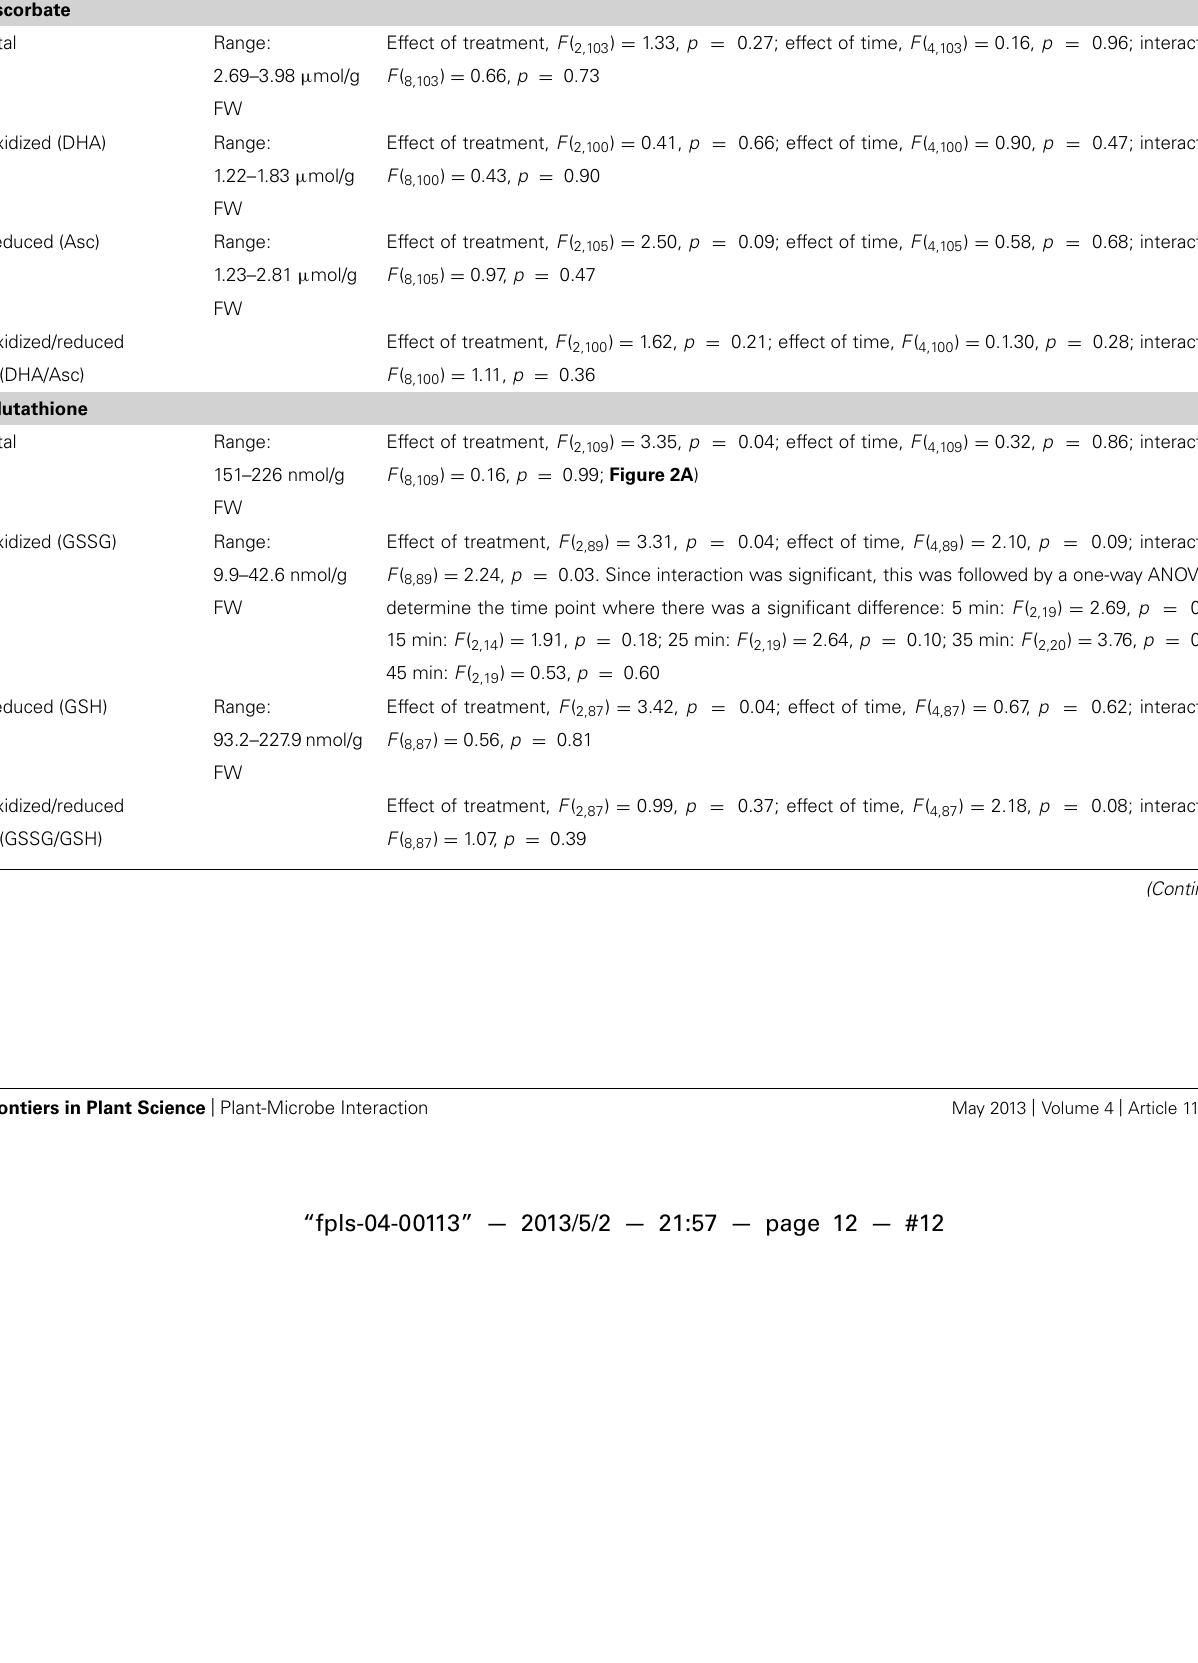
TableA2 | Statistical results of plant–insect